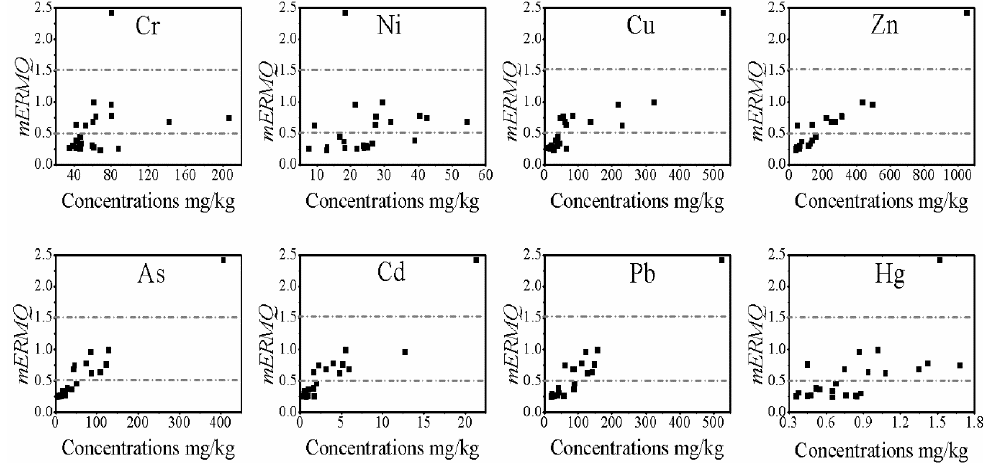
Figure 6. The mERMQ values of Cr, Ni, Cu, Zn, As, Cd, Pb and Hg in sediments based on SQG values (ERM) and total heavy metal concentrations.